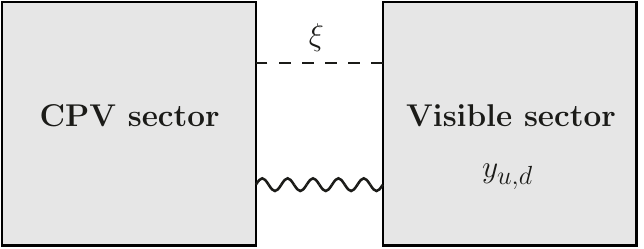
Figure 1 . Schematic picture of the setup: CP is spontaneously broken in a color-neutral CPV sector and communicated to the visible sector via a CP-odd and (cid:13)avor-violating vev (cid:24) (cid:24) 1. An example of minimal CPV sector is presented in appendix C, while two models for the messenger dynamics are discussed in section 3 and appendix A (both belong to a more general class, see eq. (3.14)). As argued at the end of this section, (cid:13)avor-violation beyond MFV is severely constrained by (1.1), whereas (cid:13)avor-conserving interactions (wavy line) are